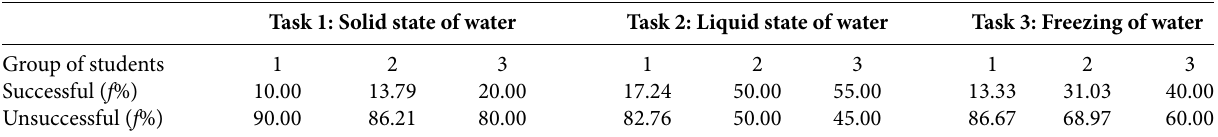
Table 1. Relative frequencies of successful and unsuccessful students at solving tasks on solid (Task 1), liquid state of water (Task 2) and freezing of water (Task 3). Task 1: Solid state of water Task 2: Liquid state of water Task 3: Freezing of